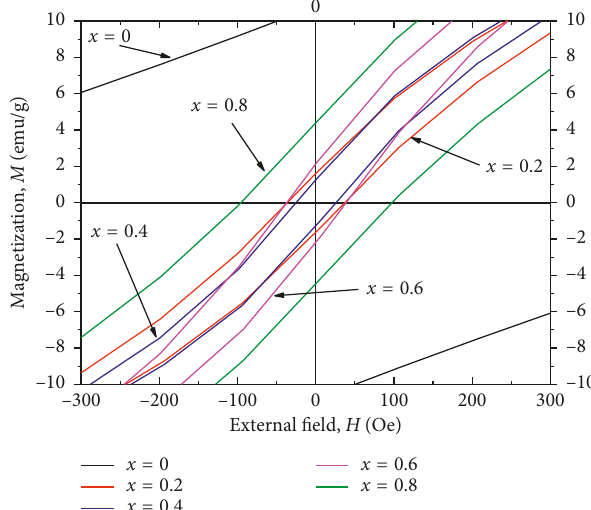
Figure 4: Hysteresis loops of Ba ( x � 0.0–0.8) samples.